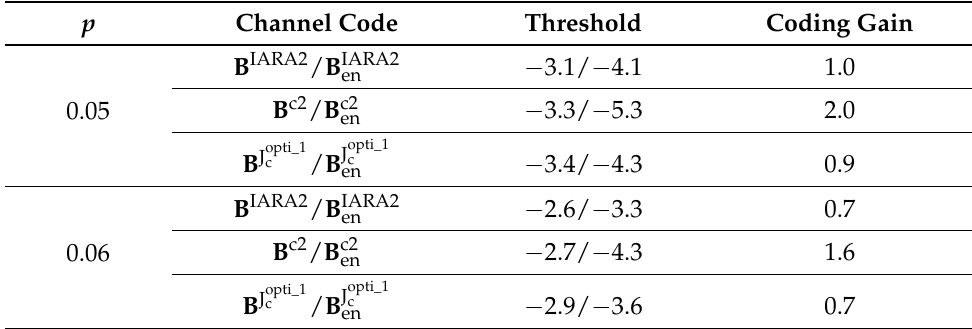
Table 1. Decoding Thresholds of the Proposed System for Different Channel Codes and Source Statis- tics.